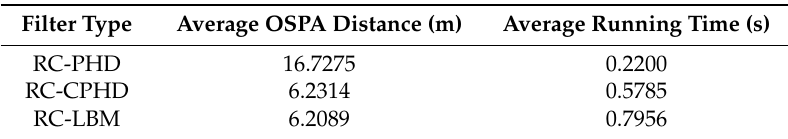
Table 9. Average OSPA distance and running time of different filters versus detection probability when the clutter rate is equal to